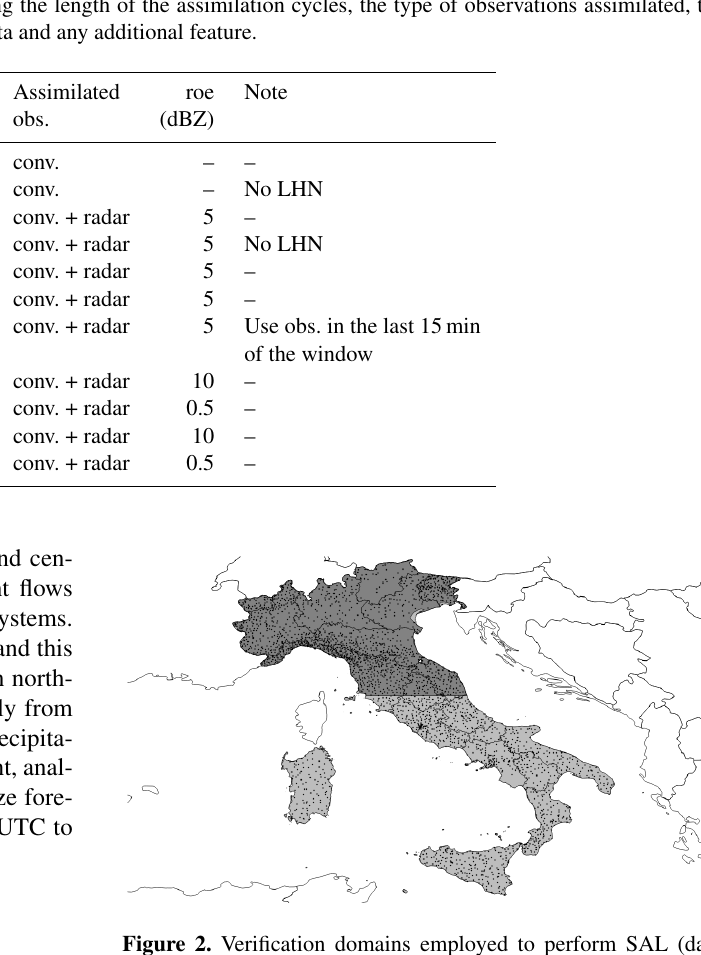
Figure 2. Verification domains employed to perform SAL (dark grey area) and FSS (union of dark grey and light grey areas). The rain gauges (black dots) are used to correct precipitation estimated from the Italian radar network. Furthermore, rain gauges over the black grey domain are employed for the verification of areal aver- age precipitation during the assimilation